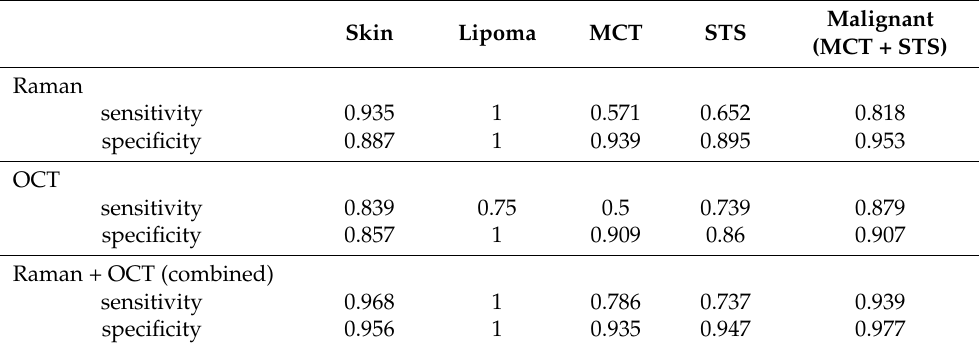
Table 2. Sensitivities and specificities for skin, lipoma, MCT, STS, and malignant (MCT+STS) tissue class. Results are based on Raman, OCT, and combined